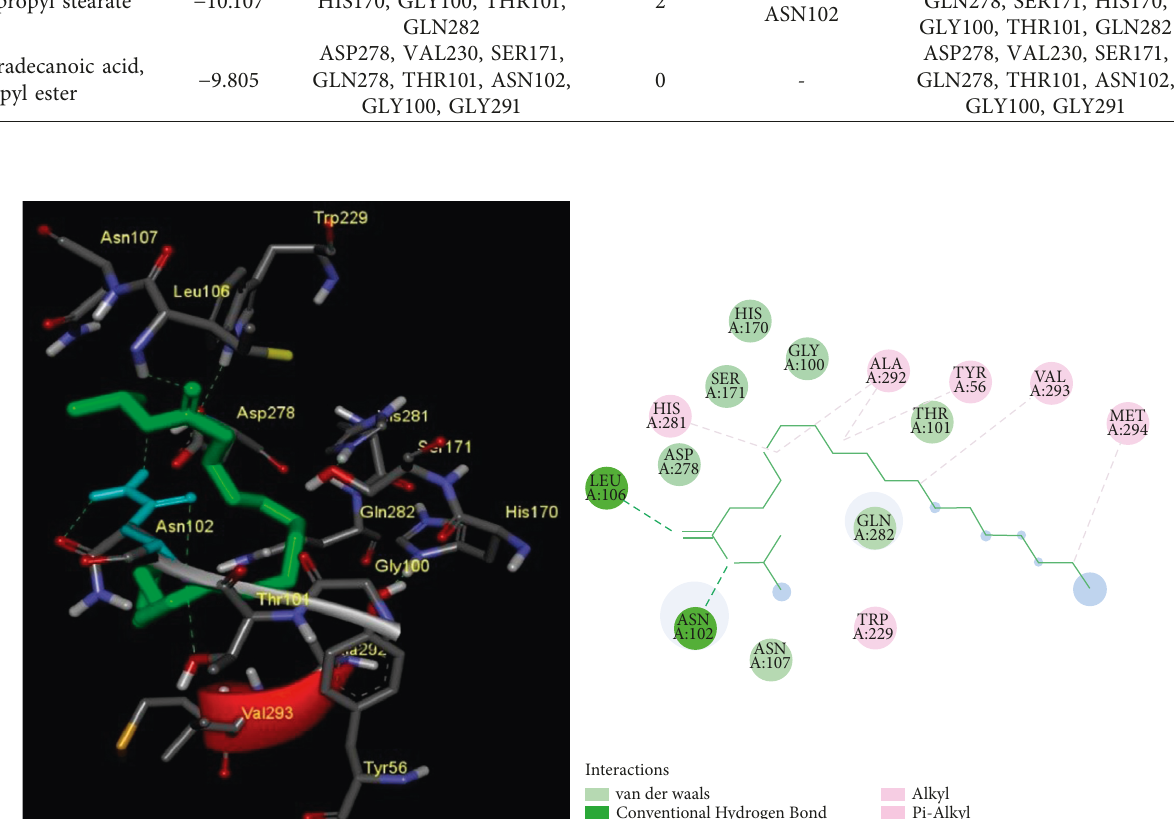
Figure 6: 2D and 3D interaction of Isopropyl stearate of binding score − 10.107Kcal/mol against lipase of Malassezia globosa